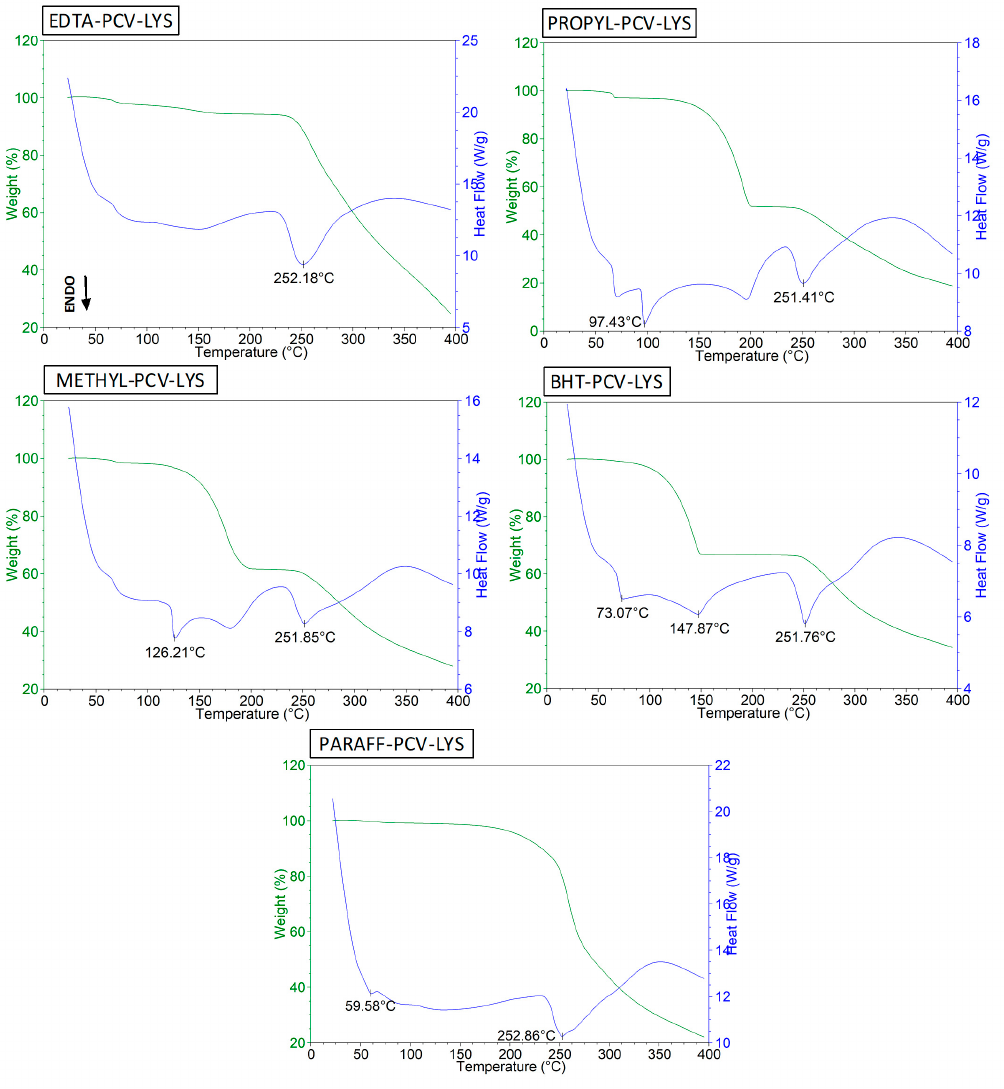
Figure 6. DSC curves of EDTA-PCV-LYS, PROPYL-PCV-LYS, METHYL-PCV-LYS, BHT-PCV-LYS and PARAFF-PCV-LYS.